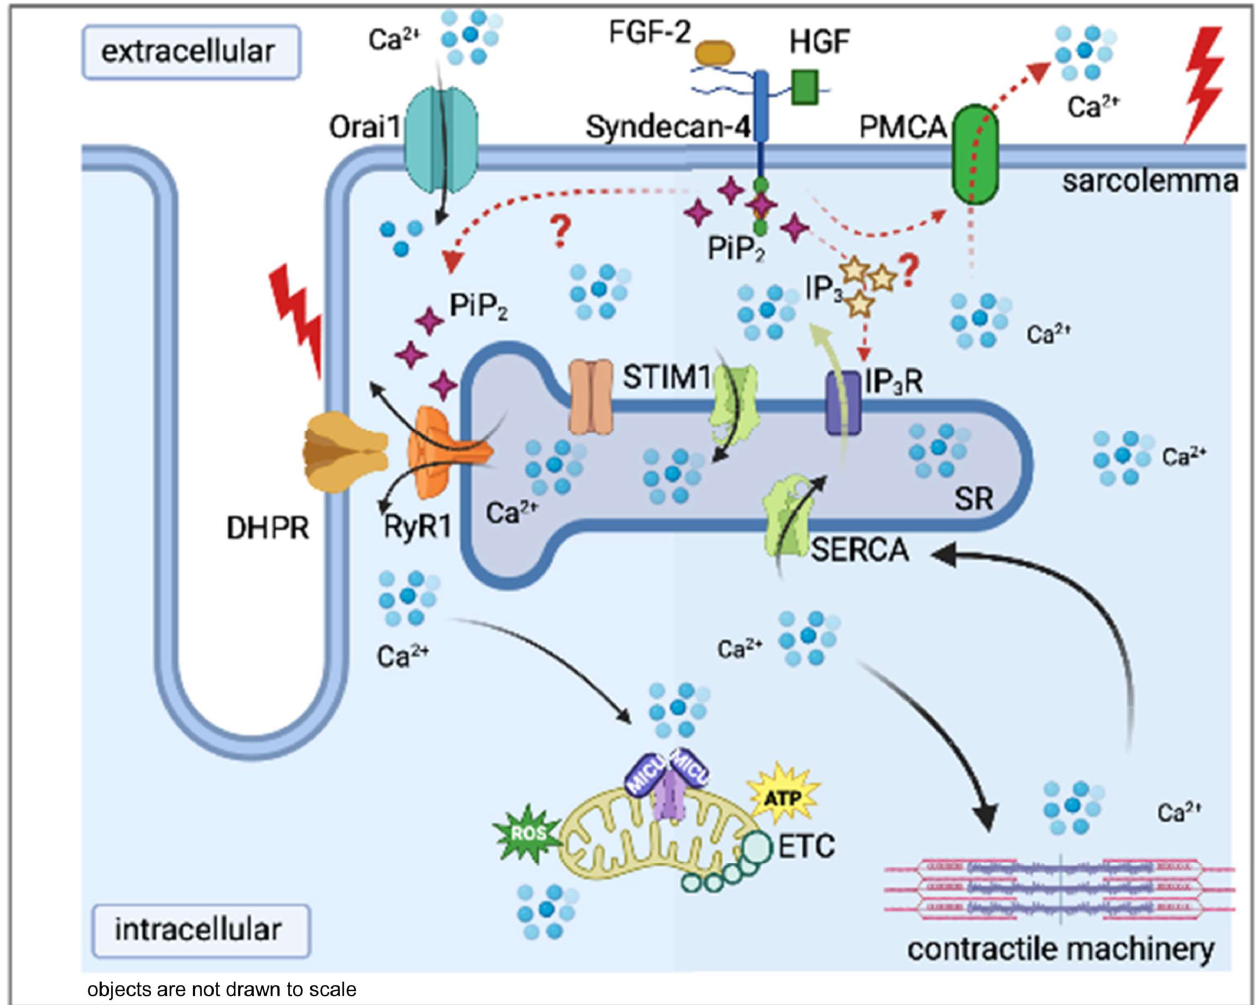
Figure 7. Proposed interactions of Syndecan-4 in skeletal muscle. Syndecan-4 may directly alter the plasma membrane calcium pump (PMCA). It may indirectly modify the opening of type 1 ryanodine receptor (RyR1) in the sarcoplasmic reticulum (SR) membrane by modifying the PiP 2 concentration in the intracellular space. The black arrows show the path of calcium ions in the intracellular space. Red arrows tackle the connection between the proposed interactions. The green arrow tackles the